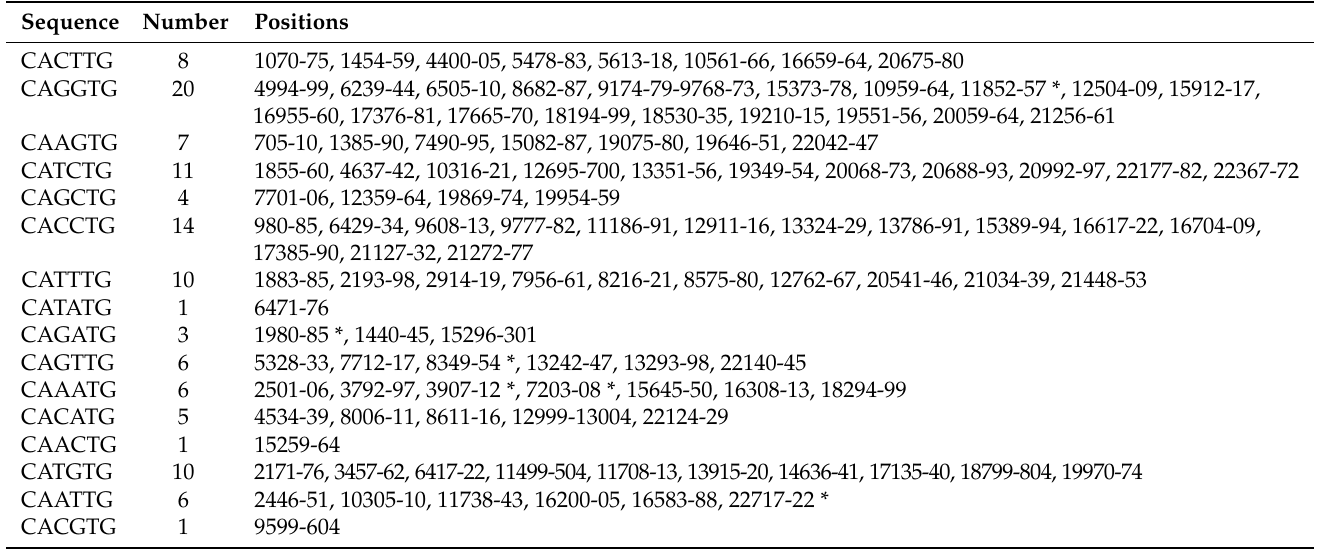
Table 4. The number and positions of E-box hexanucleotide consensus sequence (CANNTG) in DPPA2 transcription unit. The asterisks indicate exonic E-boxes.